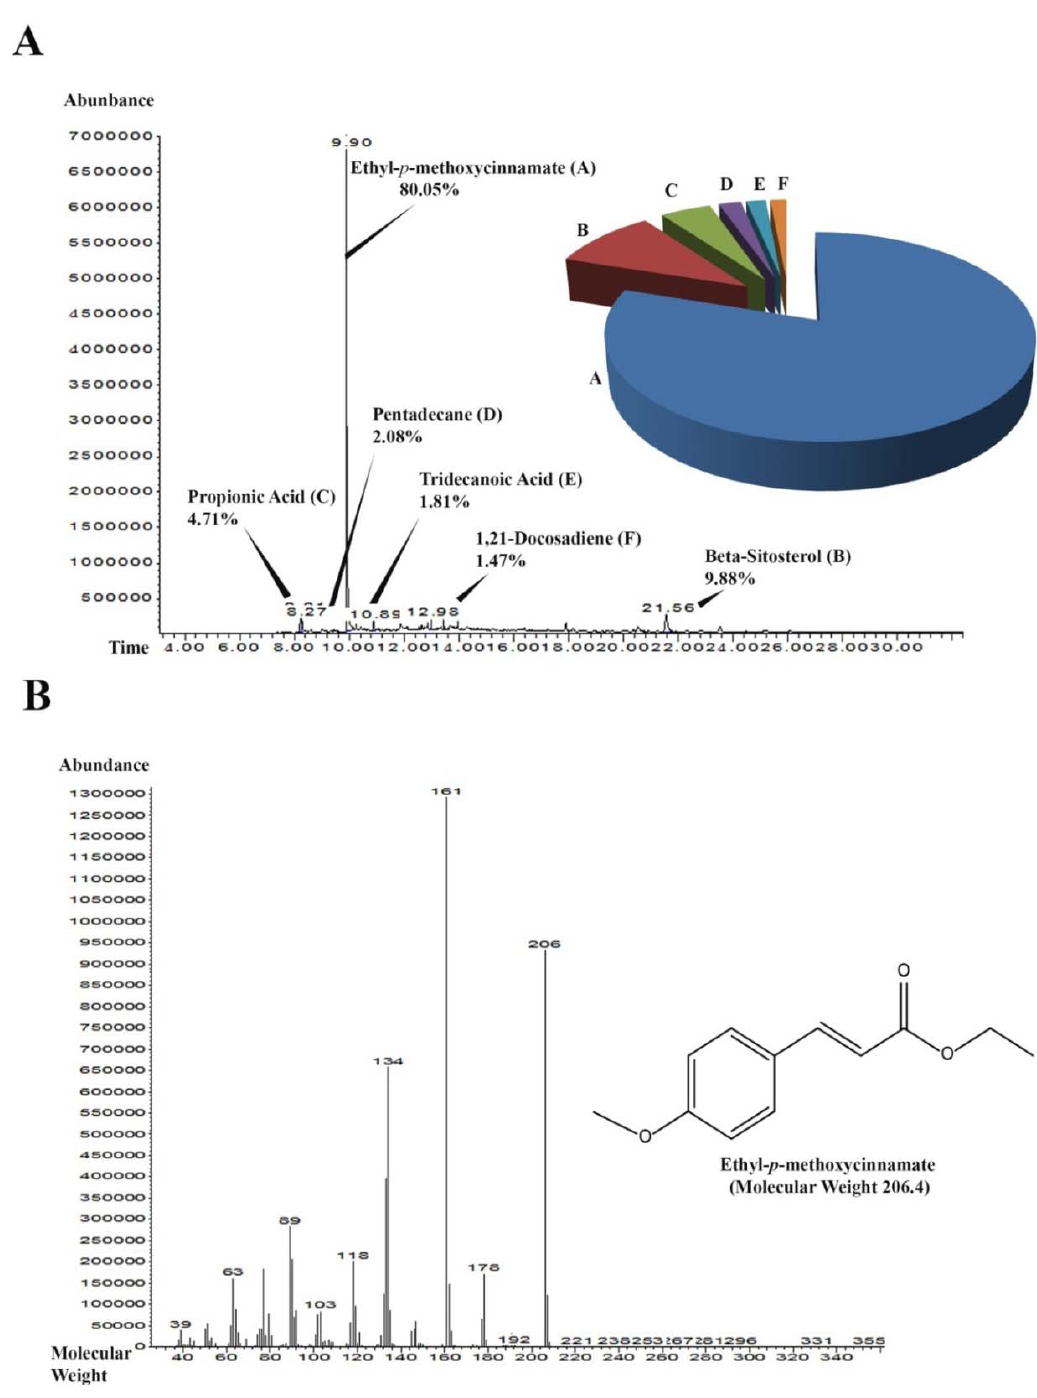
Figure 4. GC-MS chromatogram of the most effective sub-fraction (SF-1). ( A ) Peaks of the components detected in sub-fraction 1 along with their retention time. The pie chart represents the relative percentage abundance of each constituent